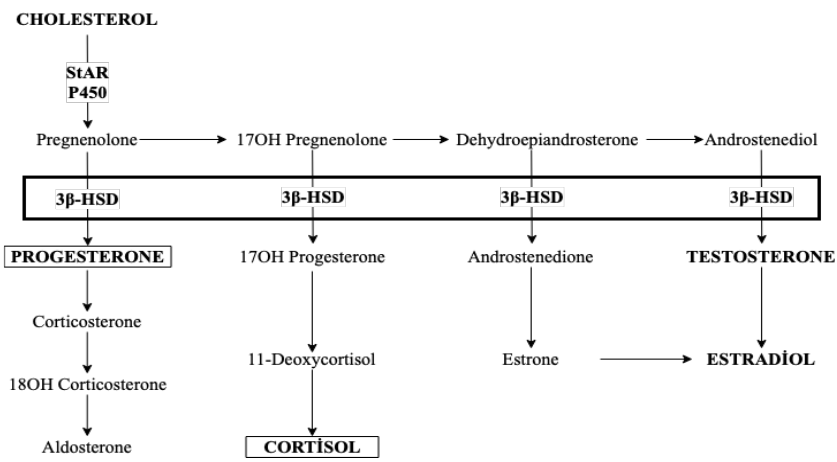
Figure 2. Diagrammatic representation of steroidogenesis. Trilostane (TRL) is a competitive inhibitor of 3 β -HSD, and its use is reported to